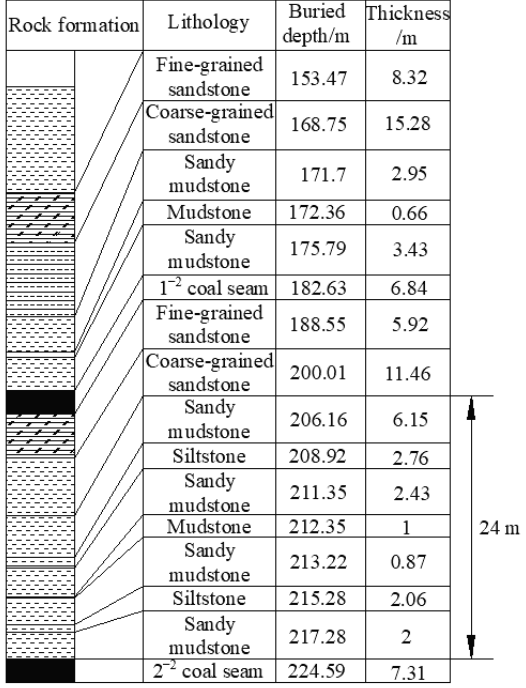
Figure 1. Plan view of the 22410 working face.